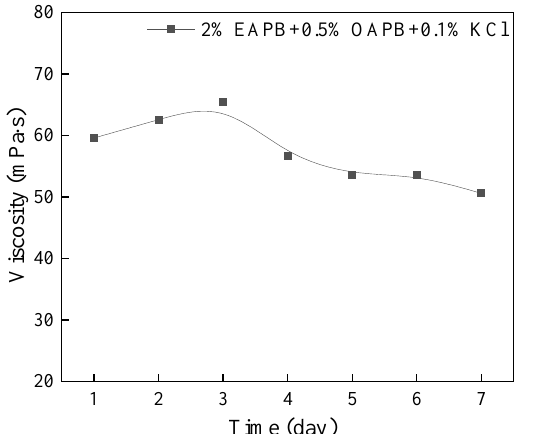
Figure 8. The apparent viscosity of the formulation at room temperature (27 °C) kept for one week (shear rare at 100 r min −1 ).